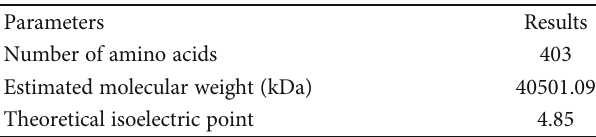
Table 1: Physicochemical evaluation of the DTL-4